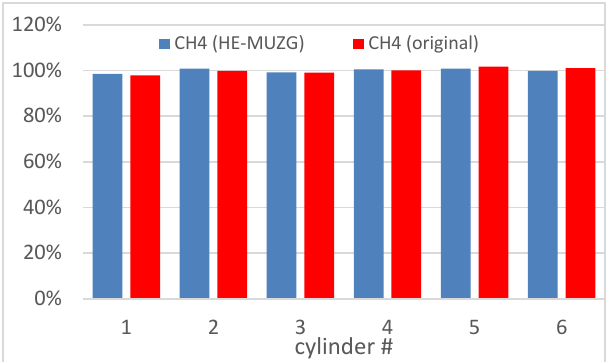
Fig. 4. Individual cylinders balancing comparison based on combustion monitoring for original mixer and HE-MUZG system(balancing referred to